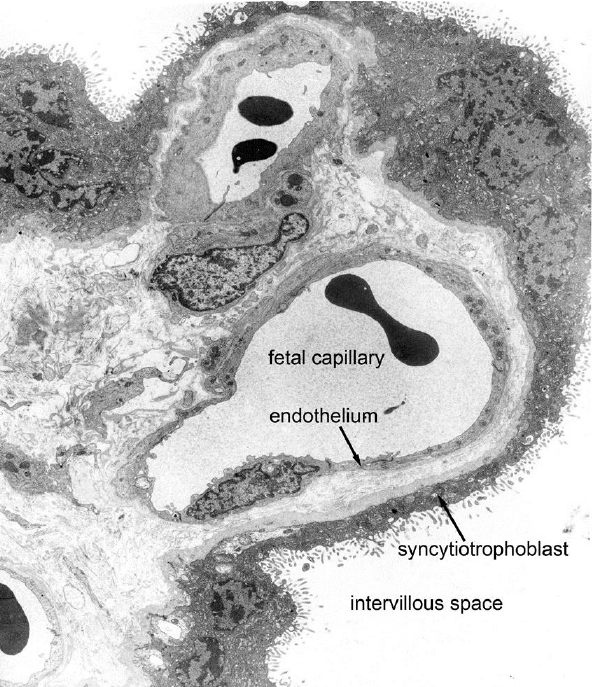
Figure 4. The interhaemal barrier of the human placenta is classified as haemomonochorial. The intervillous space is separated from blood in the fetal capillary by syncytiotrophoblast and fetal capillary endothelium with their basal membranes. A very thin layer of connective tissue cytoplasm is interposed between the two basal membranes. Courtesy of Dr. Allen C. Enders. Reproduced with permission from [35] Copyright © American Physiological Society.